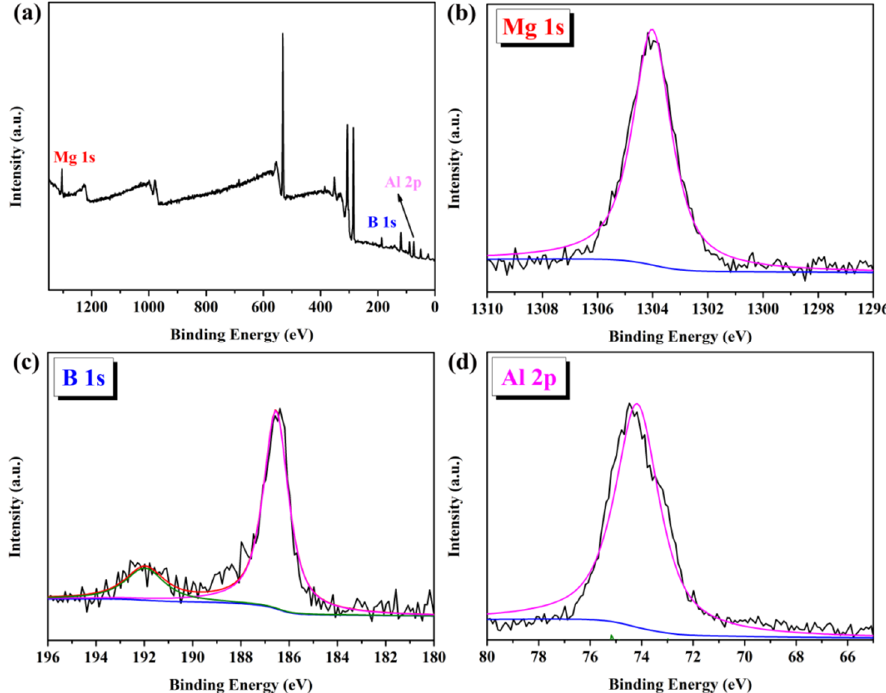
Figure 6. ( a ) Full X-ray scan spectrum of Mg 0.5 Al 0.5 B 2 ; ( b ) scan spectrum of Mg 1s; ( c ) scan spectrum of B 1s; ( d ) scan spectrum of Al 2p.